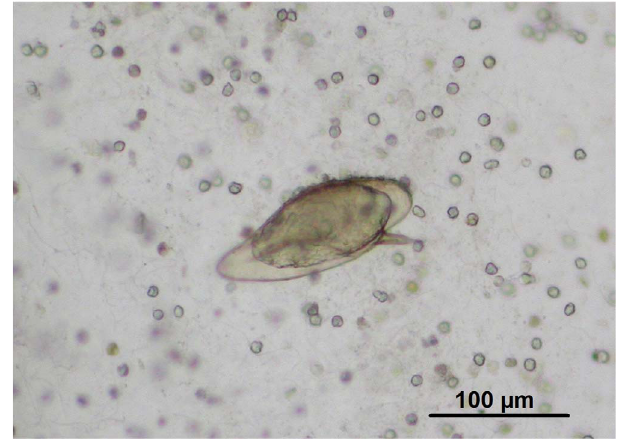
Figure 1. A hybrid S. mansoni / S. haematobium egg excreted in the urine of the